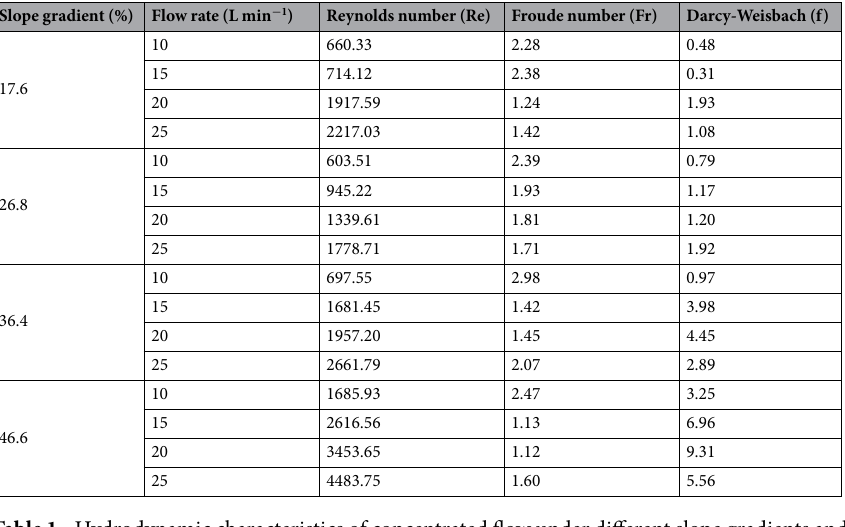
Table 1. Hydrodynamic characteristics of concentrated flow under different slope gradients and flow